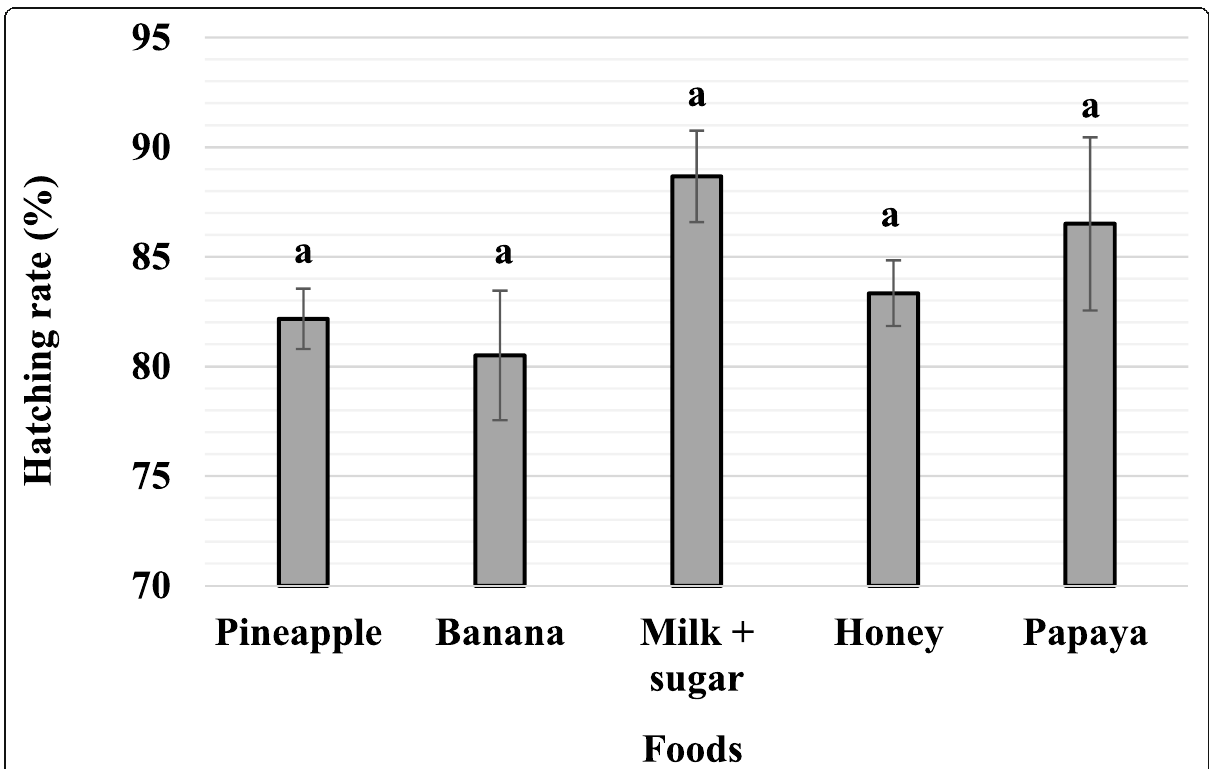
Fig. 2 Hatching rate of M. domestica eggs according to the food-based rearing system. Error bars represent standard